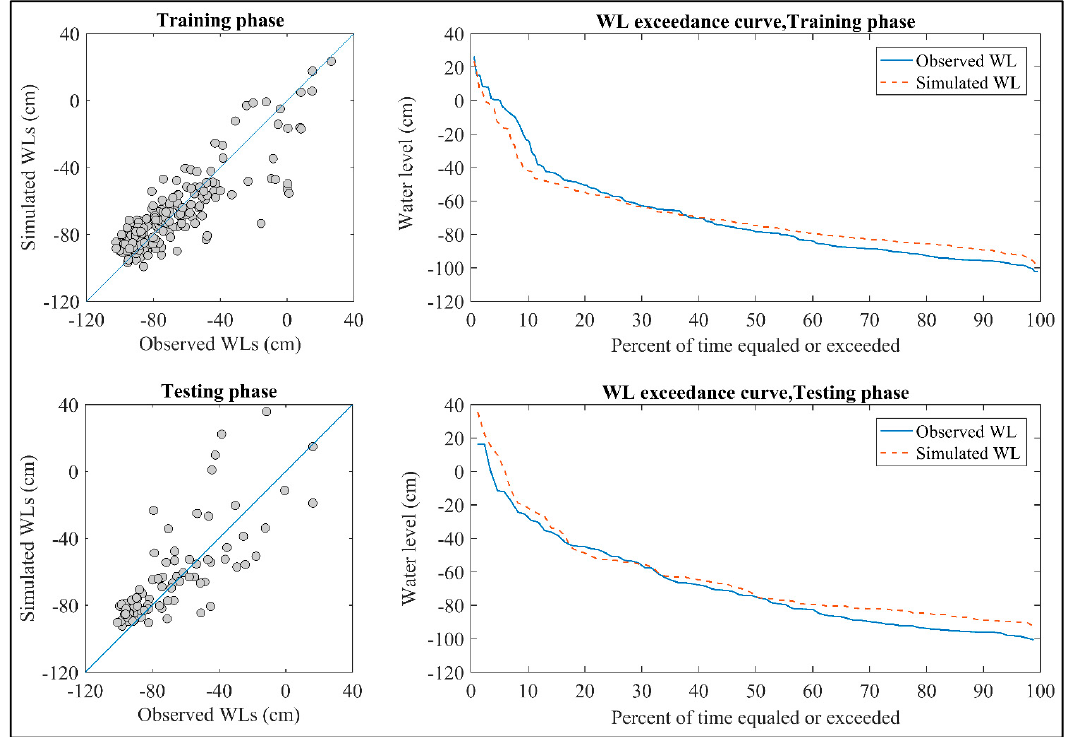
Figure 4. Simulated and observed daily average WLs for the training and testing phases in scatter plots and exceedance curves (i.e., probability of exceedance of “depth below ground surface”).